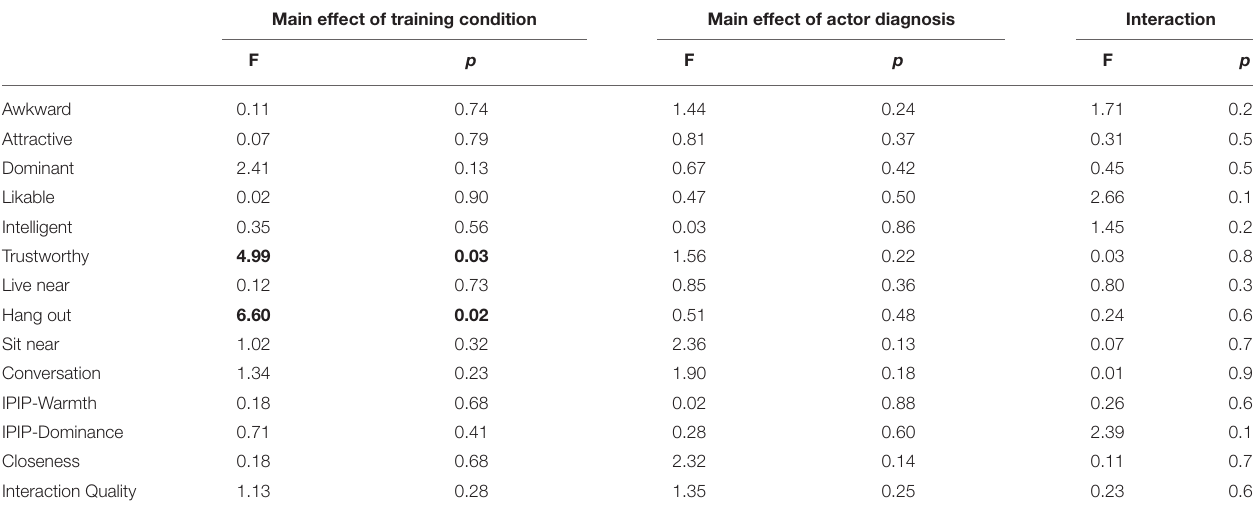
TABLE 5 | Fixed effects of training condition, actor diagnosis, and interaction on social interaction